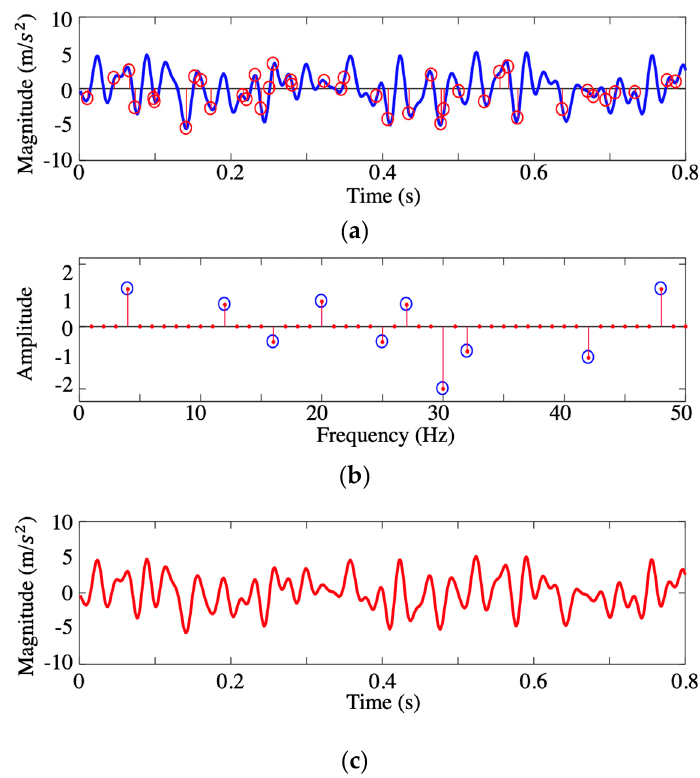
Figure 3. Example of compressive sensing (CS)-based encrypted algorithm: ( a ) Sampling points and original time-history signal containing 10 frequency components; ( b ) reconstructed sparse vector in the frequency domain; and ( c ) recovered signal from the random sampled points.